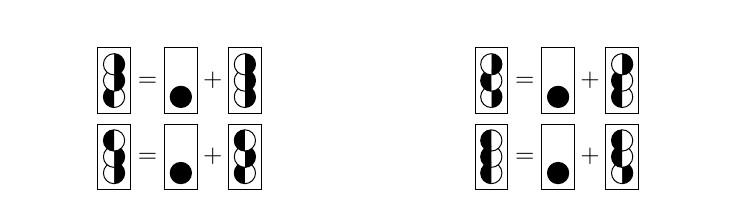
Figure 7: The odd-0 convention, illustrated. Here, each rectangle represents a column and each circle a bit. A bit can be either passive (white) or active (black). In an affected column, the left half shows the value before θ ? , while the right half shows the value after θ ? . The position y = 0 is at the